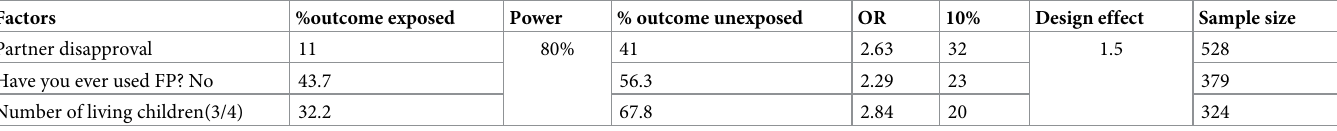
Table 1. Sample size calculation with double population proportion formula using Epi-info version 7 for the unmet need of modern FP in South Gondar, Ethiopia, 2017 [7, 9, 15]. Factors %outcome exposed Power % outcome unexposed OR 10% Design effect Sample size Partner